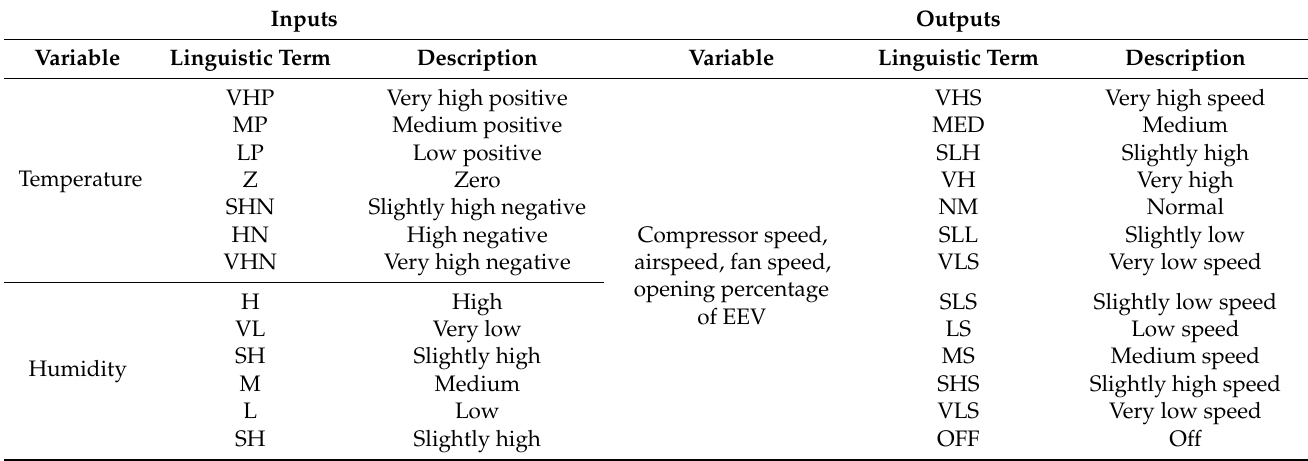
Table 1. Linguistic variables frequently used in